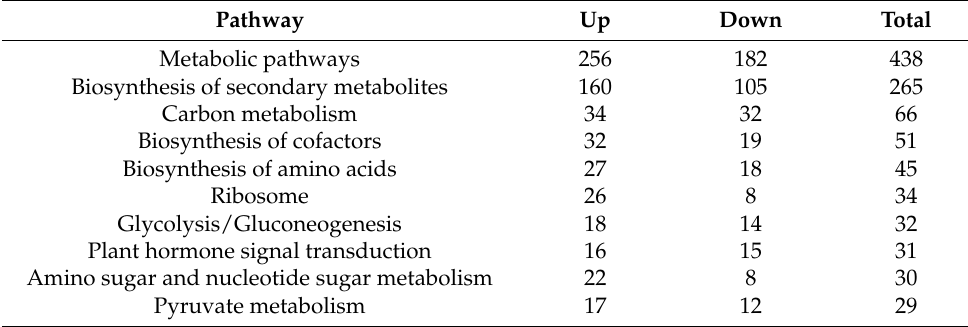
Table 5. Top 10 pathways enriched in the “H 2 O7d vs. H 2 O7d + FOL21d”